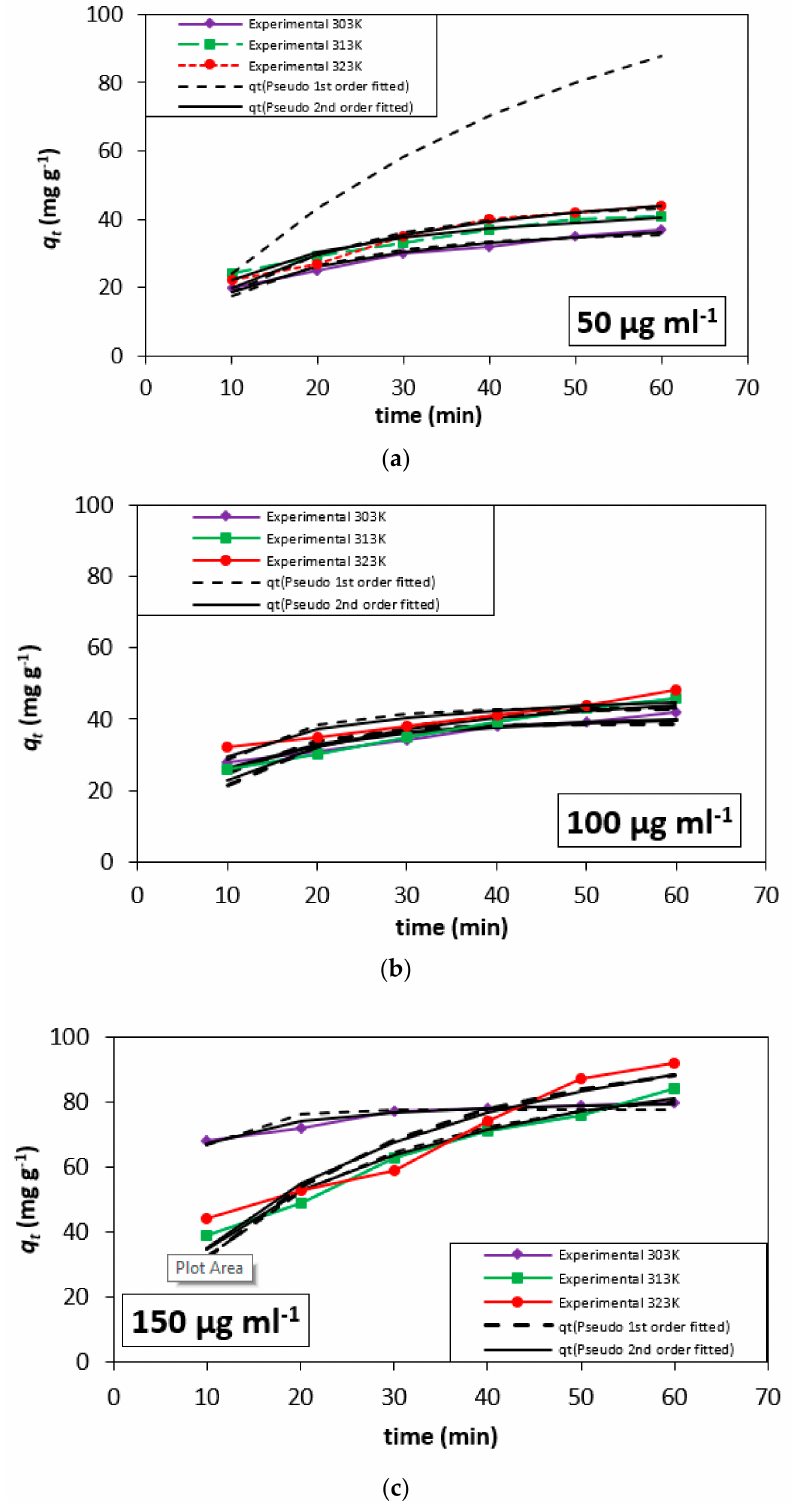
Figure 6. BG adsorption on HNT fittings for ( a ) 50 µ g/mL, ( b ) 100 µ g/mL, and ( c ) 150 µ g/mL at thermal